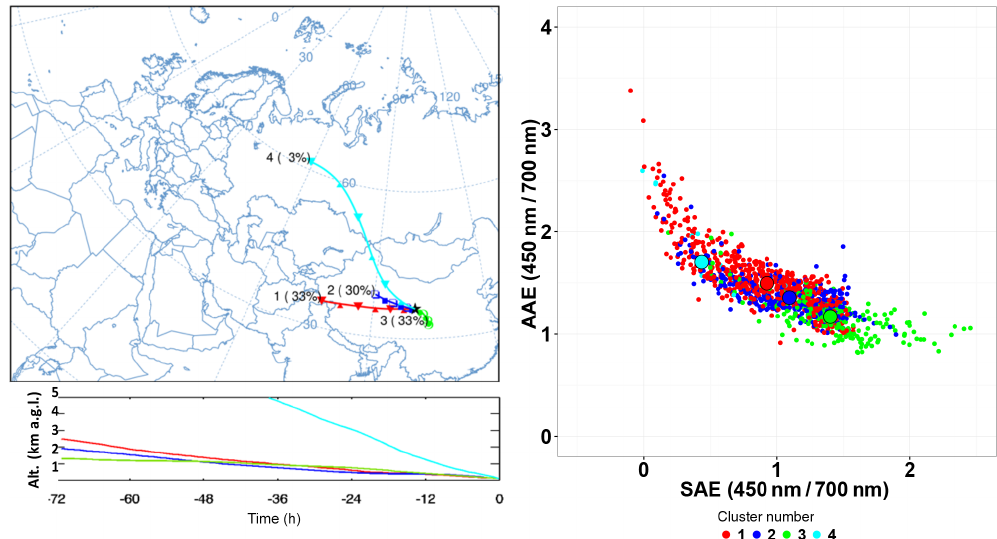
Figure 4. Back trajectory map, back trajectory height (in kilometers above ground level) vs. time and AAE vs. SAE plot space for Mt Waliguan, China, station WLG, all color-coded by back trajectory cluster number. The percentage of air mass back trajectories corresponding to each cluster are also shown next to the mean